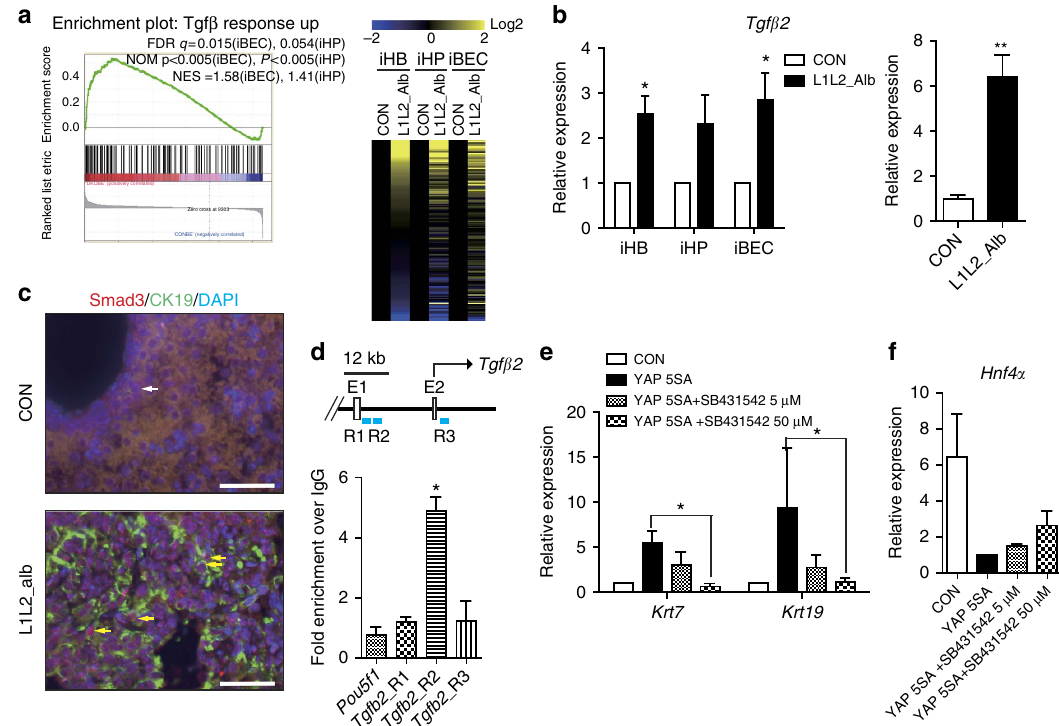
Figure 4 | Lats1/2 -deletion-induced YAP/TAZ activation activates TGF b signalling. ( a ) A signature plot of Tgf b response up-regulated gene set between Lats1/2 -deficient and control iBECs, and heat map of mRNA expression levels of Tgf b response up-regulated genes in control and Lats1/2 -deleted HBs, iBECs and iHPs. ( b ) Relative Tgf b 2 mRNA expression in HBs, iHPs and iBECs (left) and P1 livers of control and L1L2_Alb mice (right). ( c ) Representative immunofluorescence staining results obtained with anti-SMAD2/3 and CK19 in P1 livers. Yellow arrows indicate nuclear SMAD2/3 in CK19-positive cells and white arrow indicates cytoplasmic SMAD2/3 in CK19-positive cells. ( d ) Chromatin immunoprecipitation (ChIP) analysis of the Tgf b 2 locus in flag-YAP 5SA over-expressing iHPs, as performed with anti-FLAG or –YAP. ( e ) Relative mRNA expression levels of cytokeratin 7 and 19 in YAP 5SA over-expressing iBECs treated with or without the TGF b receptor inhibitor, SB431542. ( f ) Relative mRNA expression levels of Hnf4 a in YAP 5SA over-expressing iBECs treated with and without SB431542. Scale bars, 50 m m; the data are presented as means ± s.e.m.; n ¼ 3, * P o 0.05 and ** P o 0.01 (Student’s t